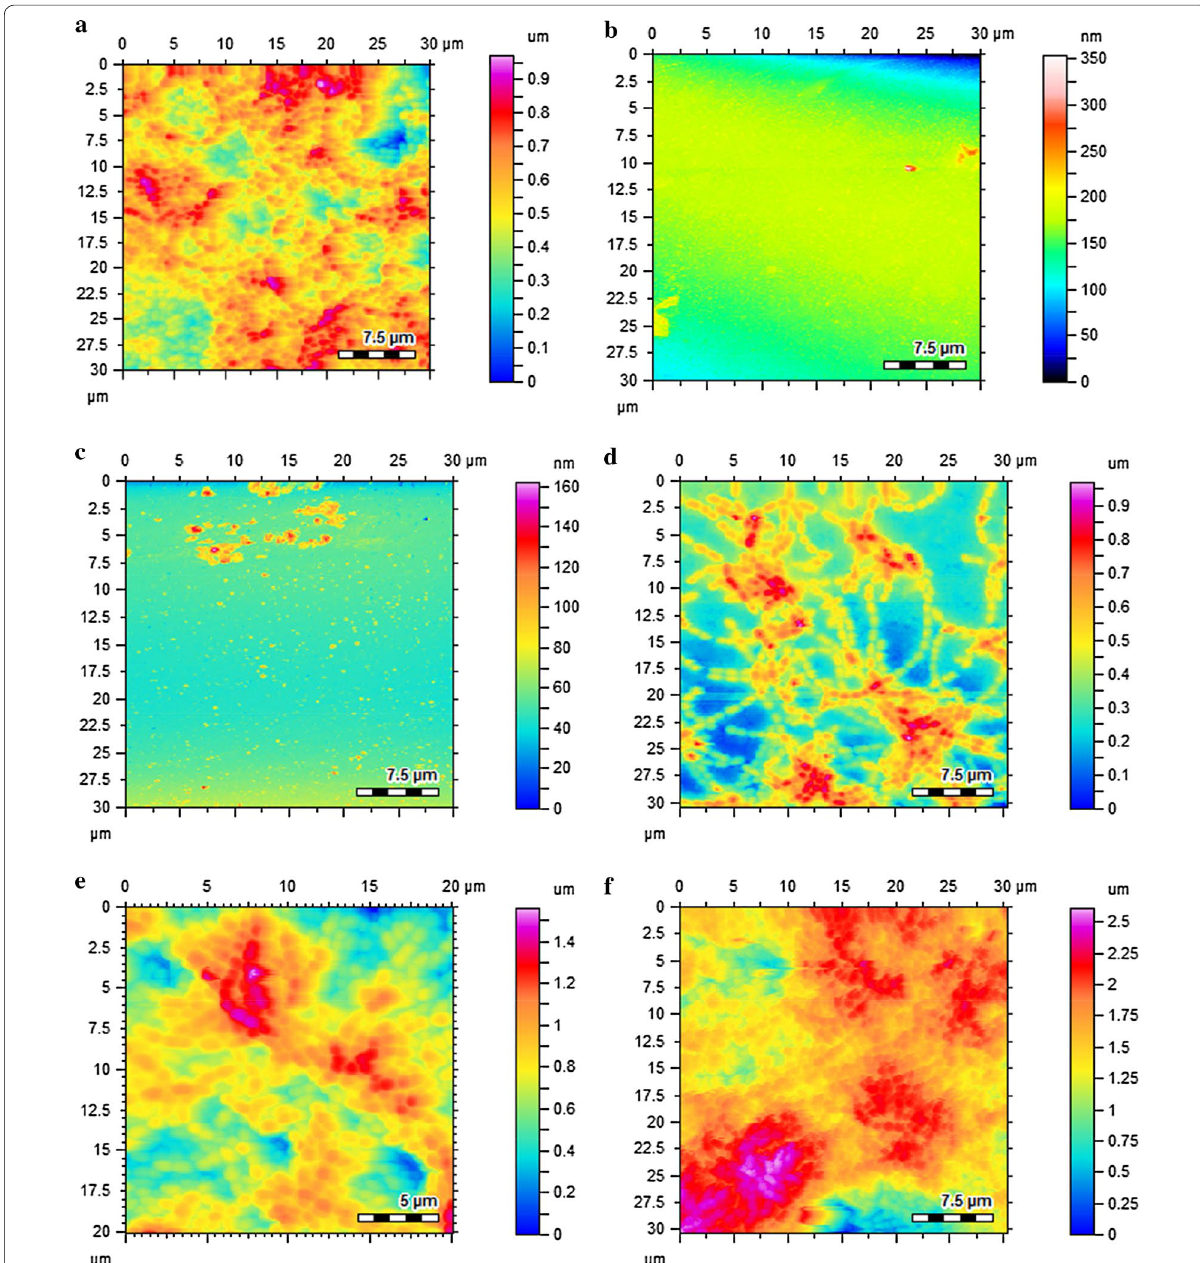
Fig. 7 AFM topographic images of S. mutans biofilms; a biofilm untreated; b Au-LPa small treated; c Au-LPa large treated; d gold nanomaterials large control treated; e gold nanomaterials small control treated; f LPa alone